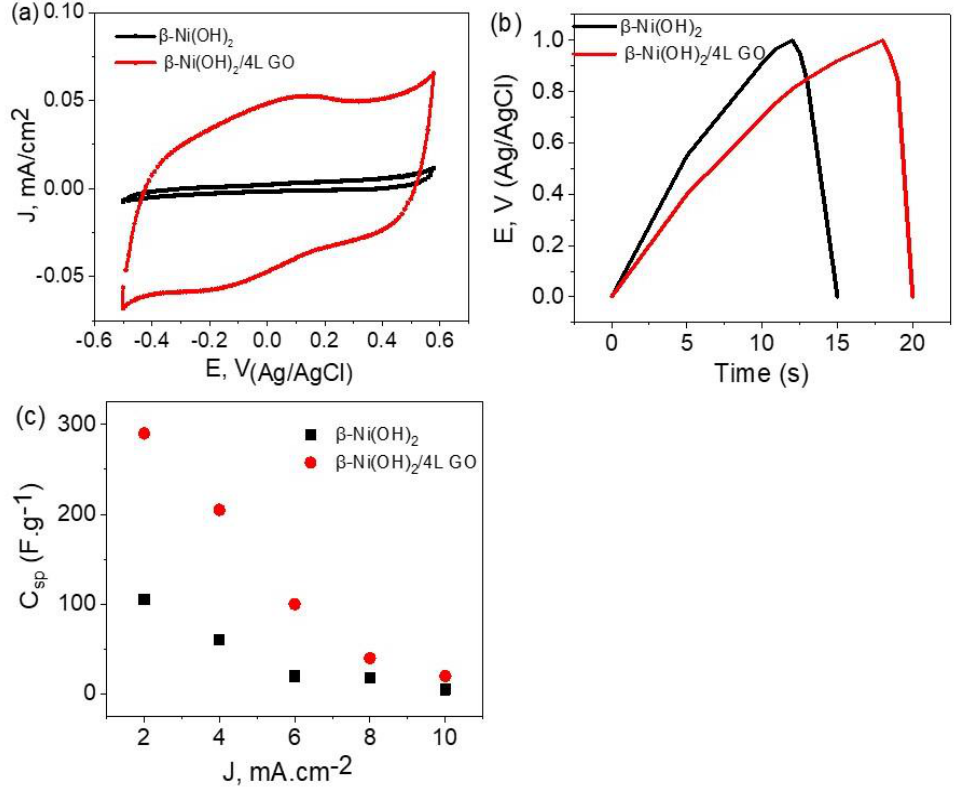
Figure 6. ( a ) cyclic voltammetry, ( b ) charge/discharge, and ( c ) specific capacitance for Ni/β - Ni(OH) 2 and Ni/β - Ni(OH) 2 /4L GO electrode supercapacitor 0.01 M nickel acetate (cycle 100) at scan rate 50 mV s −1 .